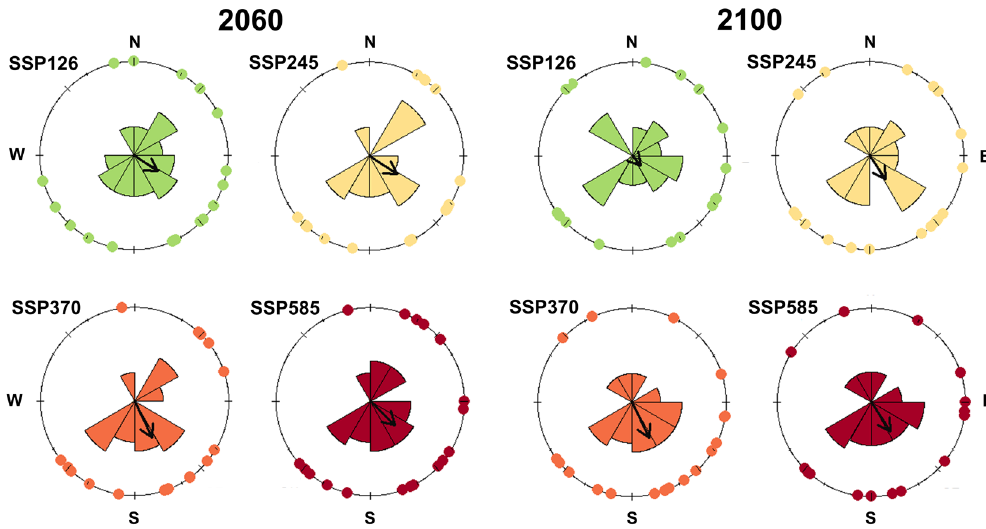
Figure 4. Circular plots showing the direction of climatic suitability distribution shifts for Atlantic Forest primate species (see Table 3 for information on the number of species) in all Shared Socioeconomic Pathways (SSP1-2.6, the most optimistic one, SSP2-4.5, SSP3-7.0 and SSP5-8.5, the most pessimist one) without considering potential dispersal. The circular mean is represented by the arrow. Leontopithecus rosalia does not have suitable areas in all 2060 and 2100 future projected scenarios and was not included in distribution shifts analysis (n = 18 in most ones). Callithrix flaviceps and L. chrysopygus do not have suitable areas in